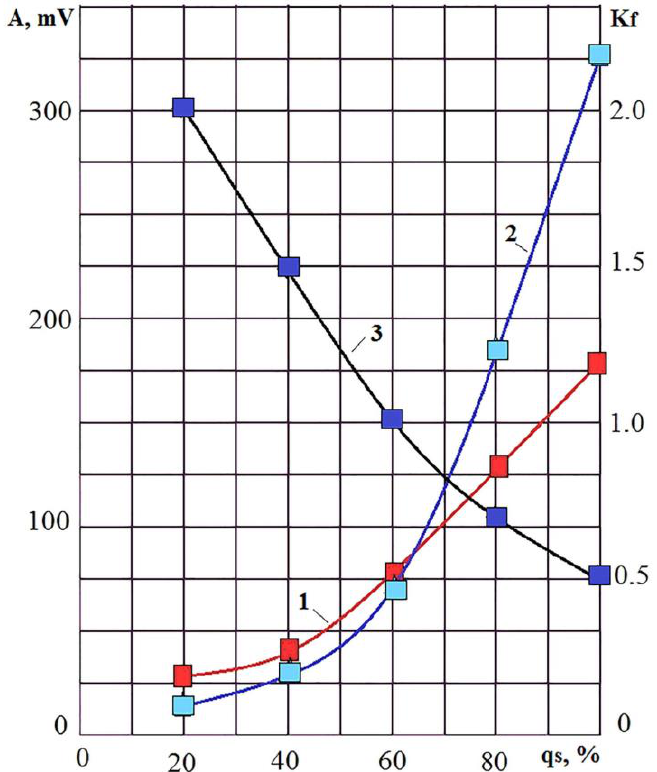
Figure 17. Changes in AE signal parameters with increasing laser power density: 1—RMS amplitude of the AE signal in the octave frequency range of 8 kHz; 2 — RMS amplitude of the AE signal in the octave frequency range of 16 kHz; 3 — K f parameter (ratio of the amplitudes of curves 1 and 2).